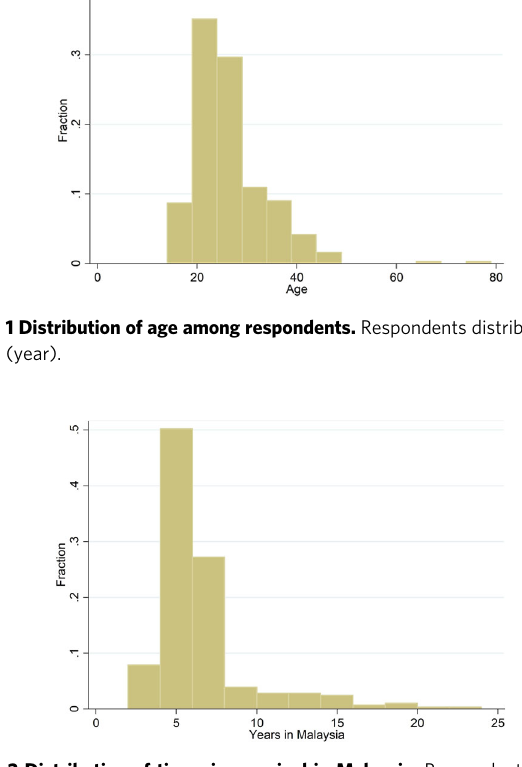
Fig. 2 Distribution of time since arrival in Malaysia. Respondents distribution by number of years since arrival in Malaysia